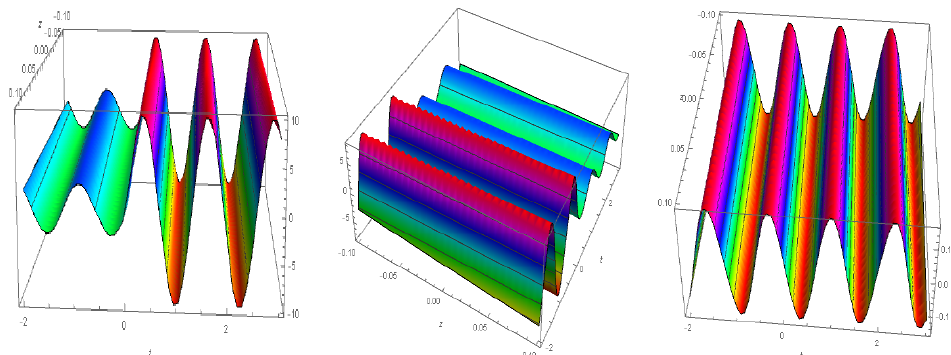
Figure 23. The soliton profiles of the solution ∆ 12 in Equation (46) are made for values of a 4 = 2, b 2 = 1, b 1 = 3, a 2 = 0.1, T r = 1, c 2 = 5, k 2 = 2 and ν = 3. Three-dimensional graphs at (i) a 3 = − 5, (ii) a 3 = 0.1 and (iii) a 5 = 4.